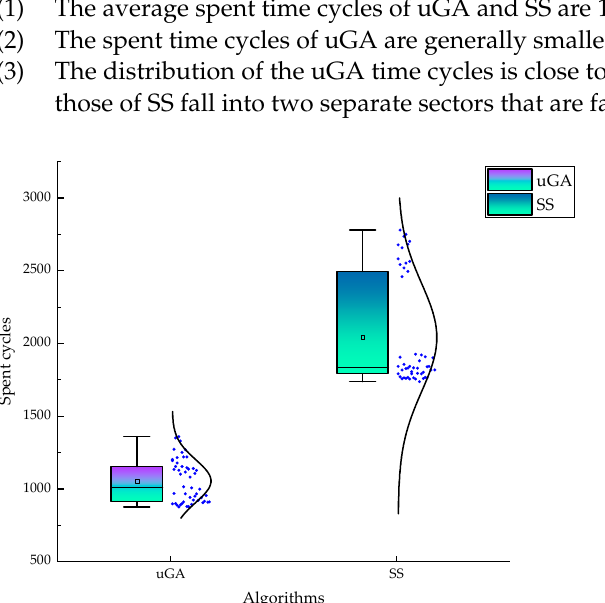
Figure 4. Box plots of the time cycles spent by the uGA and SS methods. Each box plot is based on the results of 50 trials.